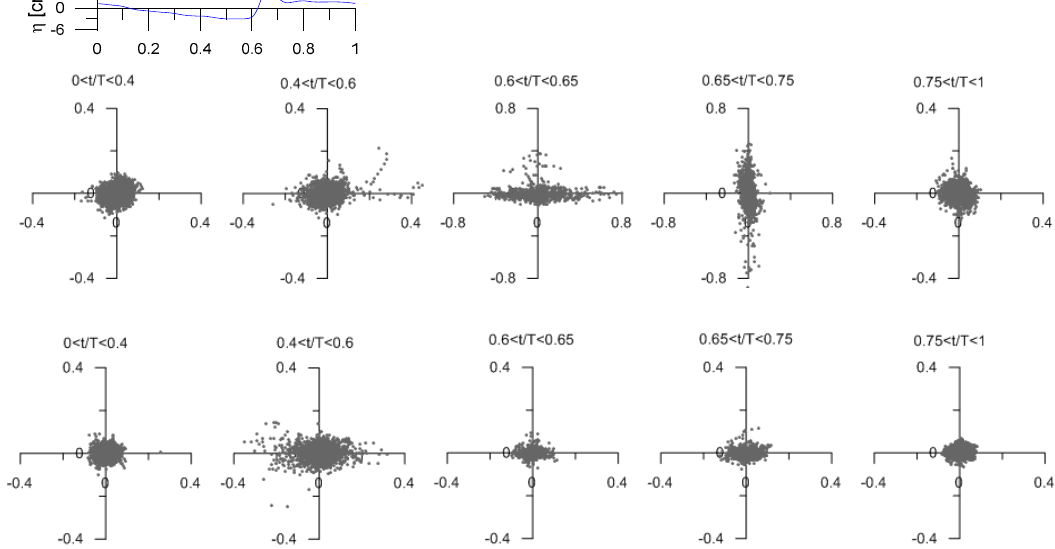
Figure 8. Test_P, sect. 47: quadrant plots in five phase intervals, at z / h = 0.7 ( top row ) and z / h = 0.2 ( bottom row ).